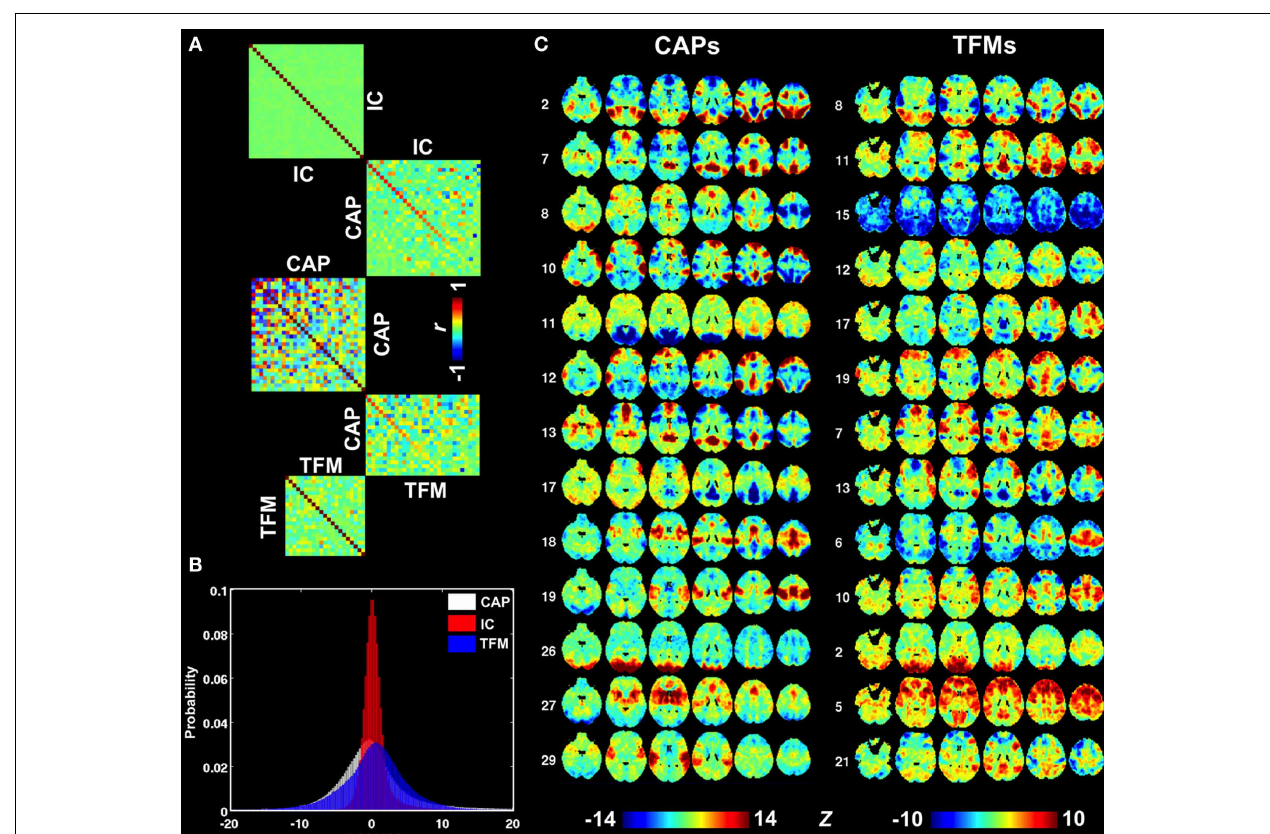
FIGURE 6 | Comparison between CAPs, ICs, and TFMs. (A) Spatial cross correlation matrices indicating substantial differences between CAPs (middle) on one hand and ICs and TFMs on the other (top and bottom, respectively). Cross-modality correlations were sorted based on correlation strength. (B)